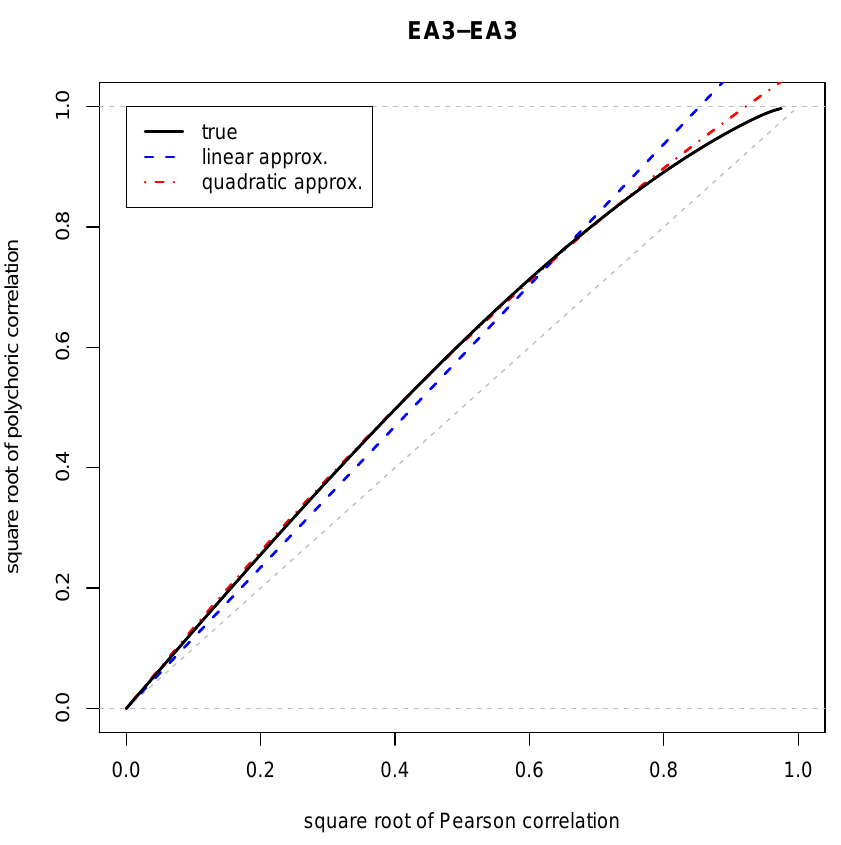
√ ρ ∗ ) and the square root of the